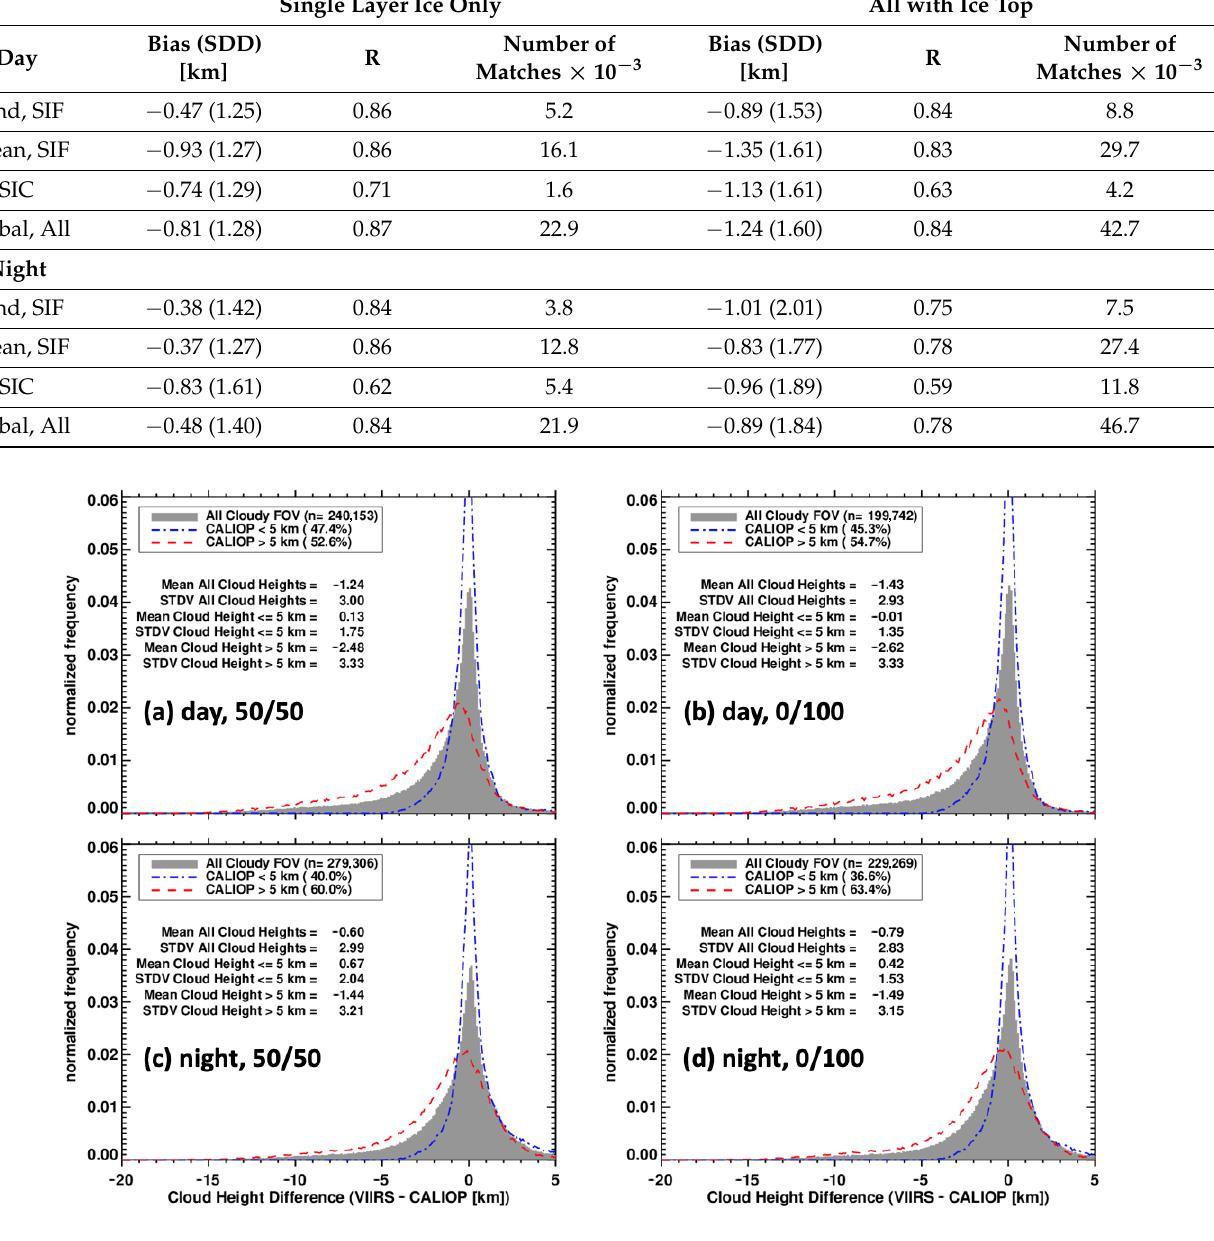
Figure 9. Probability distributions of cloud-top height differences, CTH V − CTH C , regardless